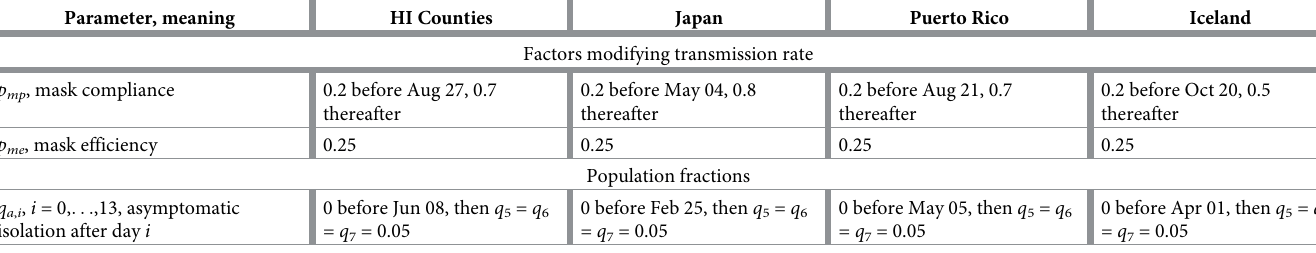
Table 2. Geographically dependent factors modifying transmission